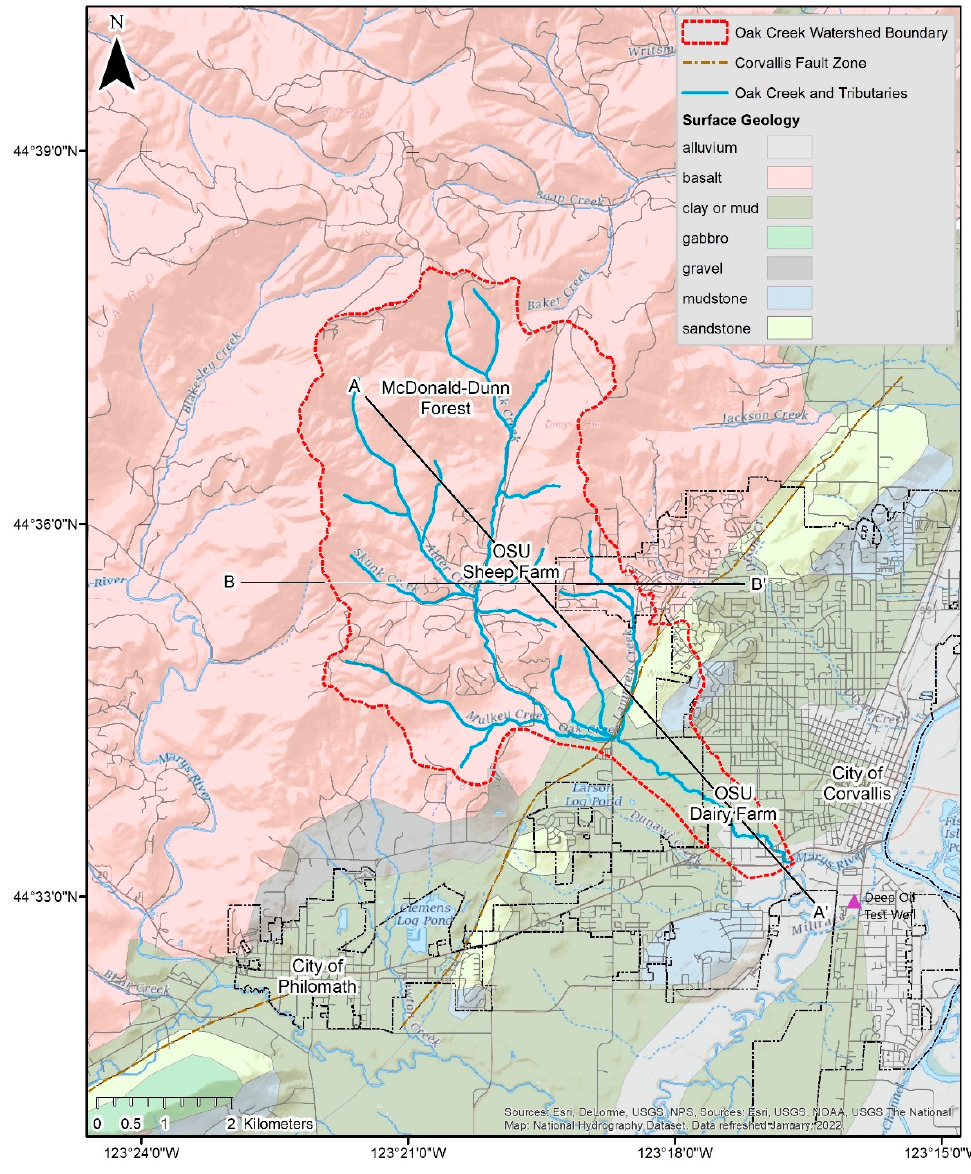
Figure 1. Surface geology map showing geologic cross-section locations and the main geologic fea- tures in the Oak Creek Watershed (OCW) and the surrounding region including Corvallis, Philomath, and Oregon State University (OSU).